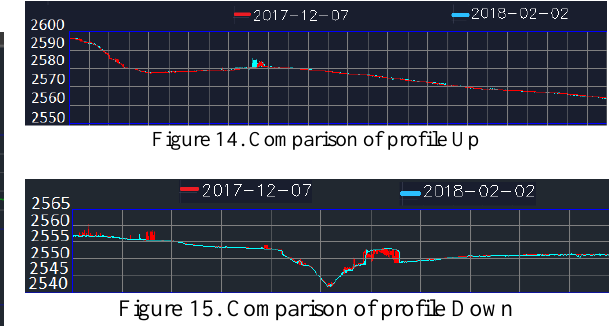
Figure 15. Comparison of profile